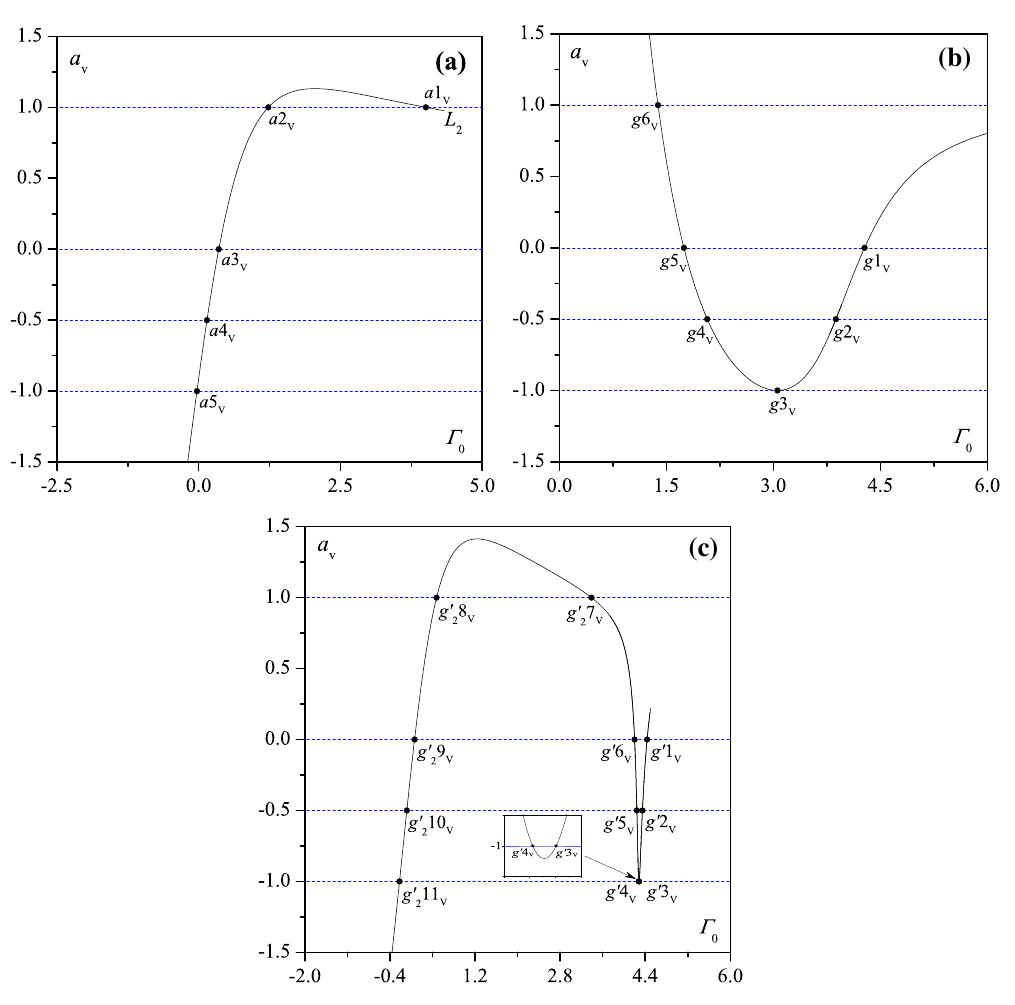
Figure 2. Vertical stability diagrams of ( a ) family a , ( b ) family g and ( c ) family g (cid:48) . ai v , i = 1,2, . . . ,5, gi v , i = 1,2, . . . 6 and g (cid:48) i v , i = 1,2, . . . 11, denote the VC or VSR orbits of the respective